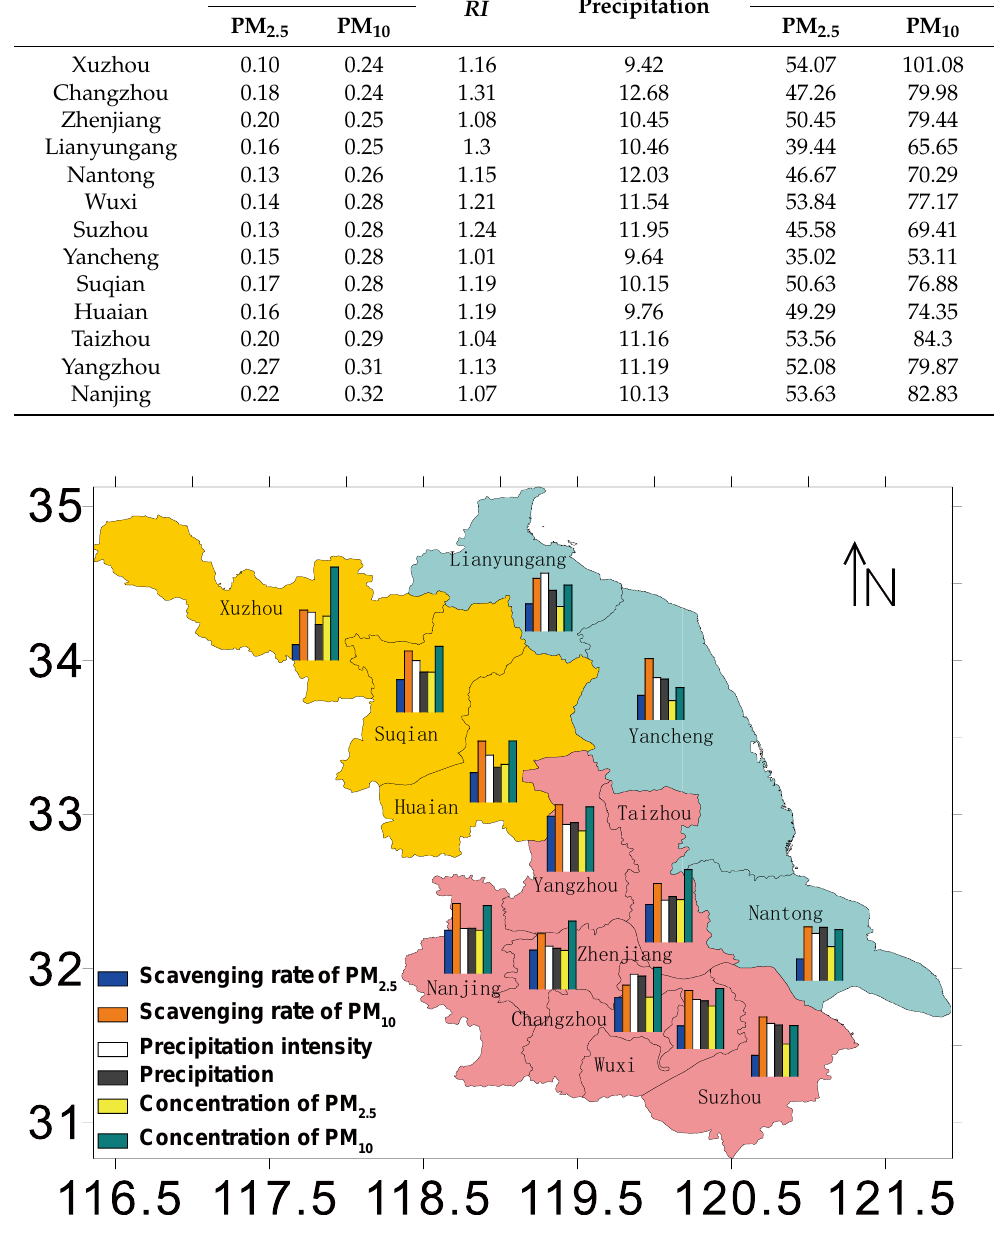
Figure 6. Relationships between precipitation, RI , particle mass concentration, and SR in Jiangsu from 2013 to 2017 (the data in Table 1). (The average PM concentration is based on the mean hourly particulate concentration of all stations in each city over a five-year period. The average values of precipitation and the precipitation rate are the average values of all precipitation processes in the region in 5 years. Three colors in the map: red, the southern inland area; blue, coastal areas; and orange, the northern inland area.) Table 1. Relationships between precipitation, RI , particle mass concentration, and SR in Jiangsu from 2013 to 2017 (data are consistent with Figure 6).